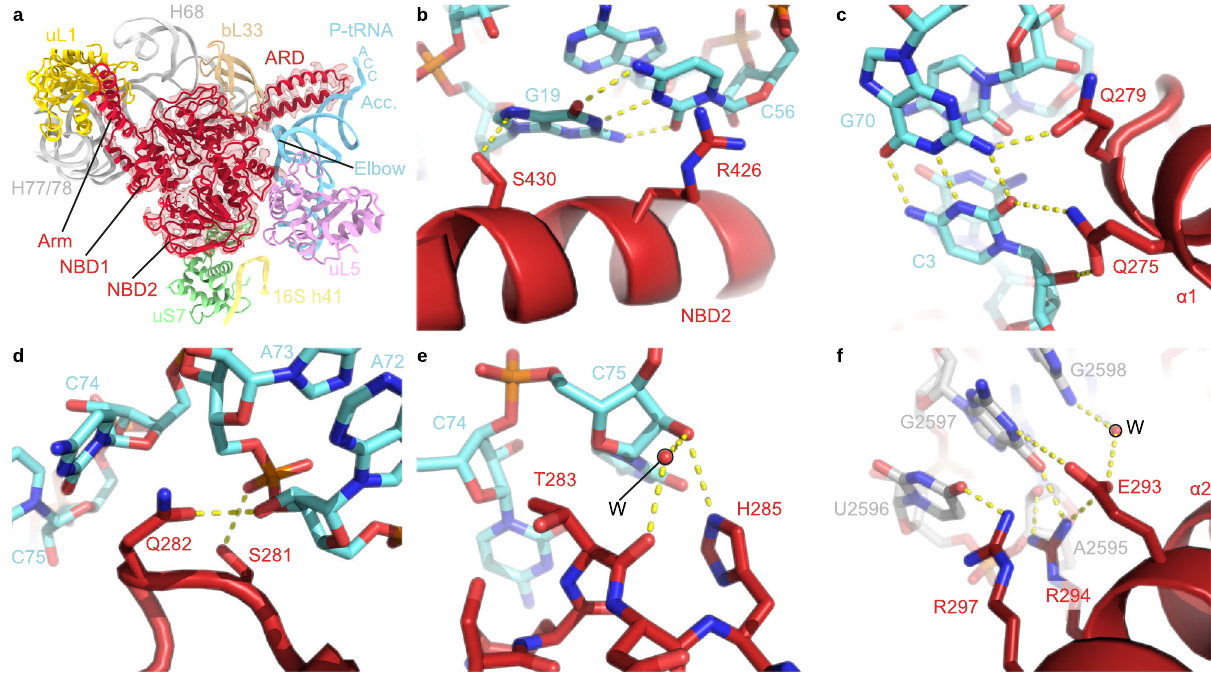
Fig. 4 Interactions between PoxtA and the ribosome-P-tRNA complex. a Overview of PoxtA interactions with the 23S rRNA (grey), 16S rRNA h41 (yellow), uL1 (gold), uS7 (green), uL5 (pink), bL33 (tan) and the P-tRNA (light blue). The P-tRNA CCA 3 ʹ end, acceptor stem (Acc.), and elbow are indicated. b – e Interactions between the P-tRNA elbow (light blue) and the PoxtA NBD2 ( b ), the P-tRNA acceptor stem (light blue) and the PoxtA ARD ( c ), the ARD and the P-tRNA CCA-end, including a modelled water molecule (labelled W) ( d , e ). f An interaction between the PoxtA ARD α 2 and the 23S rRNA. The high-resolution model from the combined 70S volume was